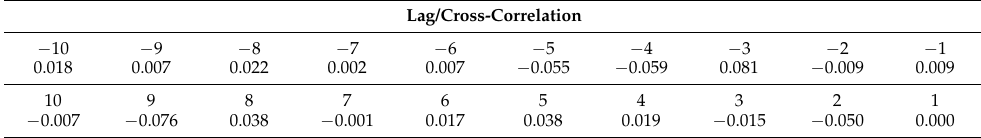
Figure 14. Cross-correlation between variations in post/topic ratio and value. Table 4. Values in the lag window (variations in post/topic ratio and